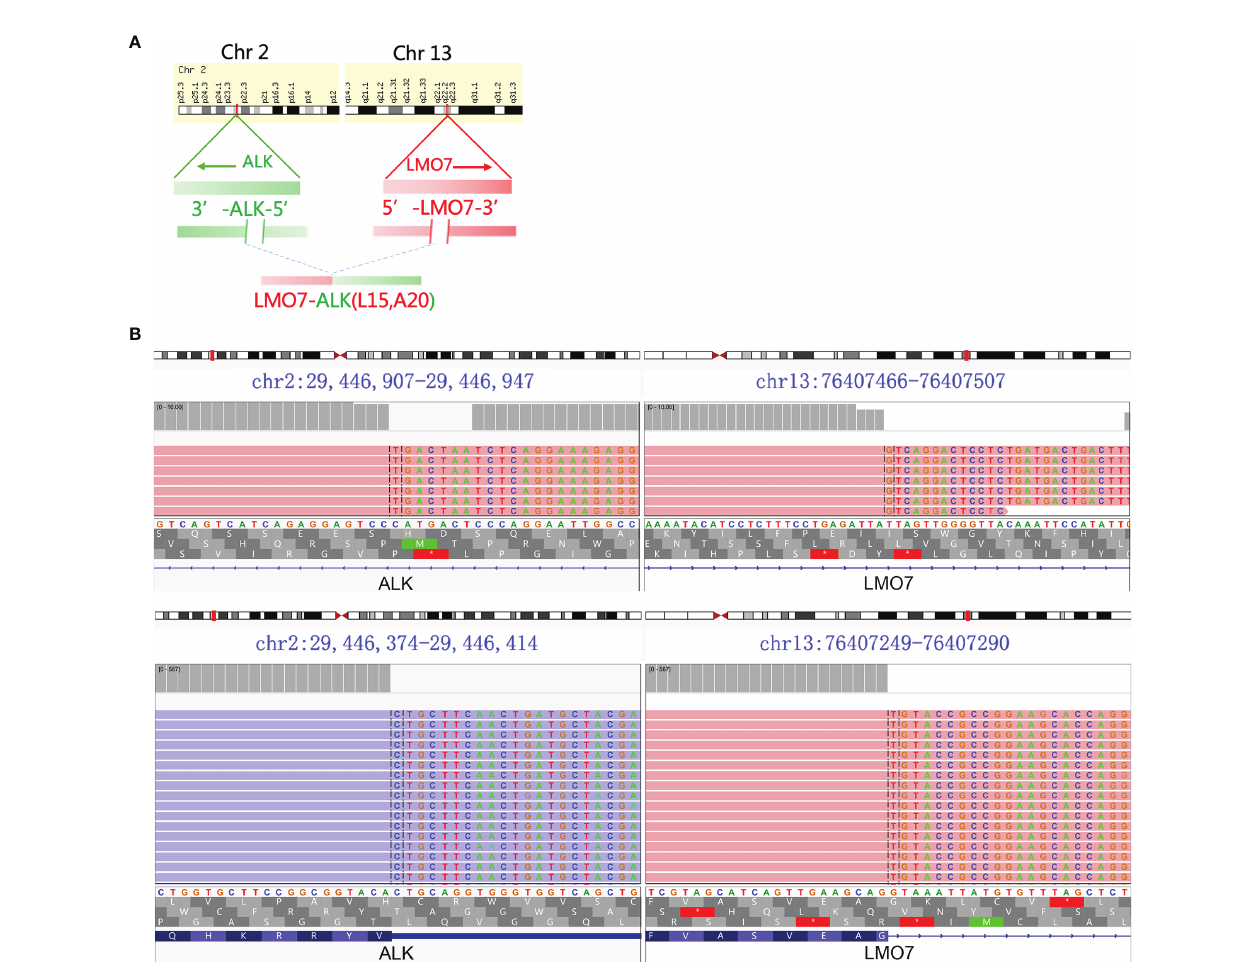
FIGURE 2 | ALK fusion was detected using NGS. (A) Schematic representation of LMO7-ALK (L15, A20). (B) LMO7-ALK (L15, A20) fusion demonstrated by Integrative Genomics Viewed